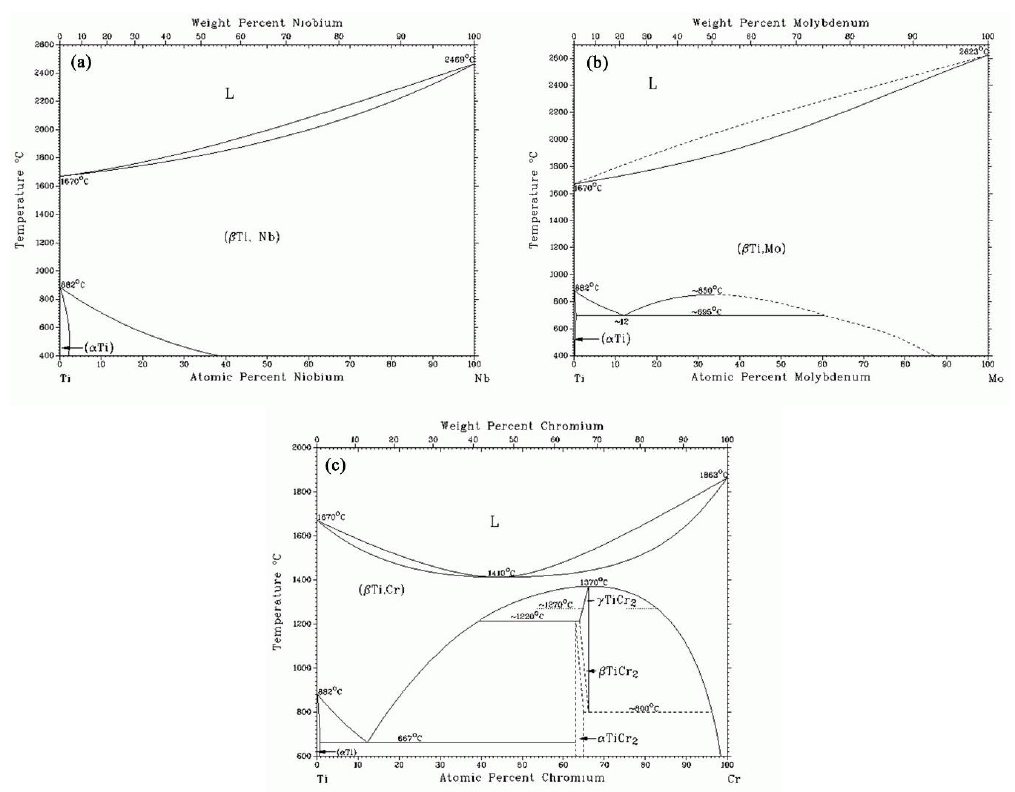
Figure 1. Example titanium binary phase diagrams illustrating an isomorphous phase diagram with no miscibility gap in ( a ) Ti-Nb, an isomorphous phase diagram with a monotectoid reaction in ( b ) Ti-Mo, and an eutectoid phase diagram in ( c ) Ti-Cr [37,38].